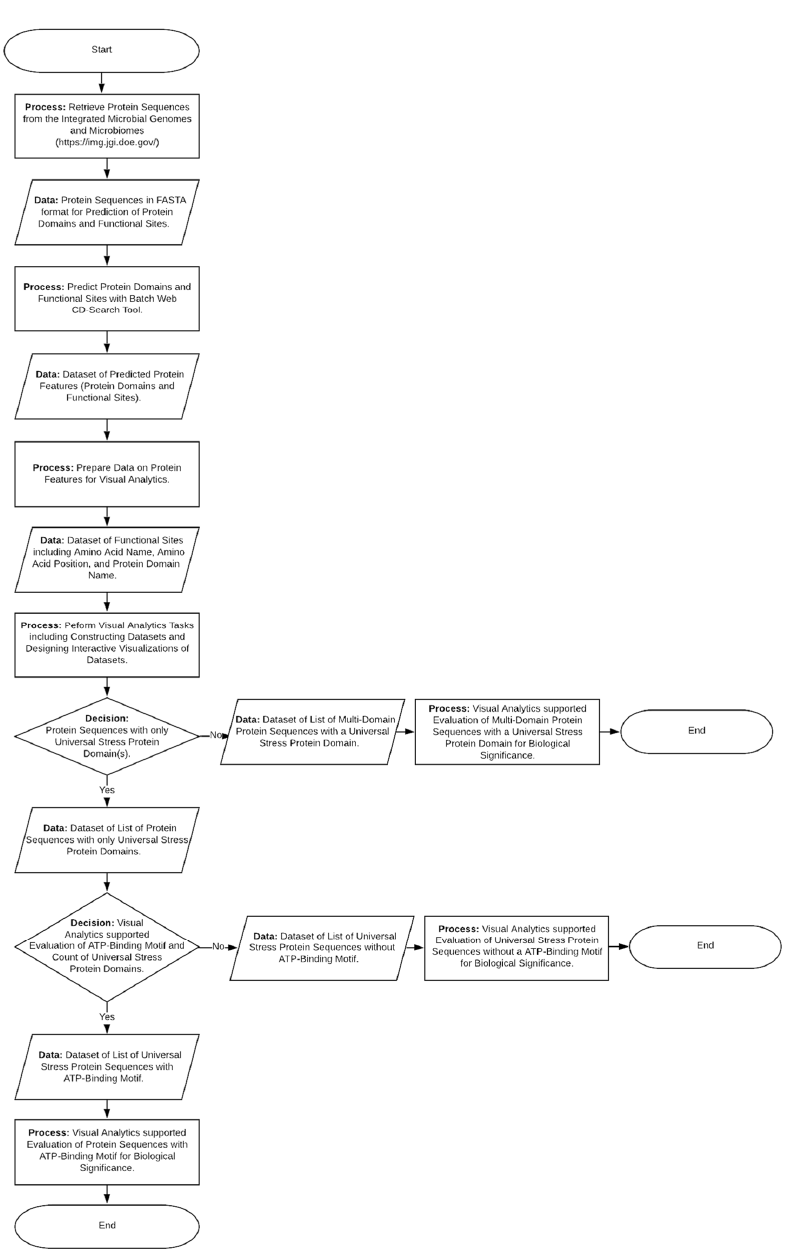
Figure 1. The U.S. Department Joint Genome Institute’s (JGI) Integrated Microbial Genomes and Microbiomes (IMG/M) system [33] was the key bioinformatics resource for collecting and interacting with protein sequence data. We also applied the Batch Web Conserved Domain Search (CD-Search) Tool of the National Center for Biotechnology Information (NCBI) [34] to obtain the number and the protein domain composition as well as the amino acid functional sites.